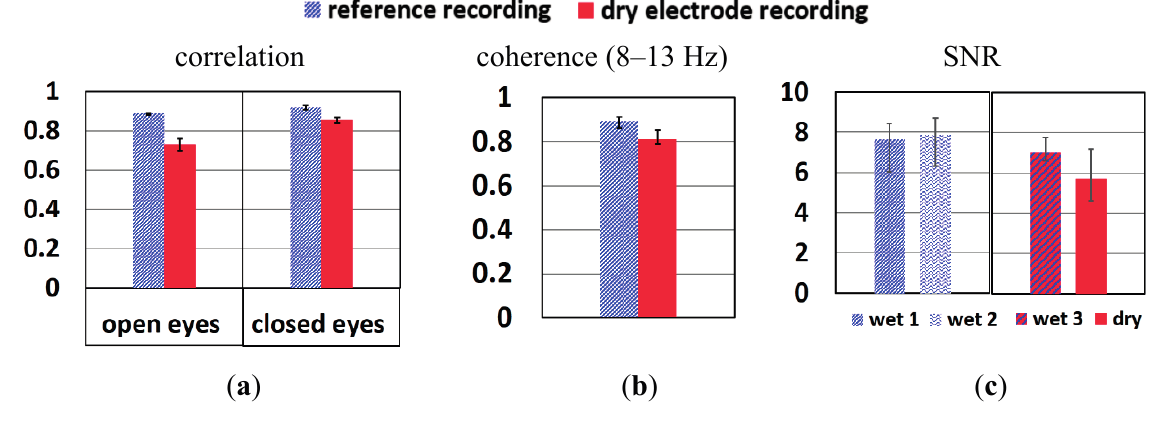
Figure 12. ( a ) Correlation when subject’s eyes open and closed; ( b ) Coherence when subject’s eyes closed; ( c ) SNR of each electrode of the wet gel electrodes (reference) and dry electrode recordings. The average value from three test segments of each recording condition is shown. The error bars indicate the best and worst result of the three